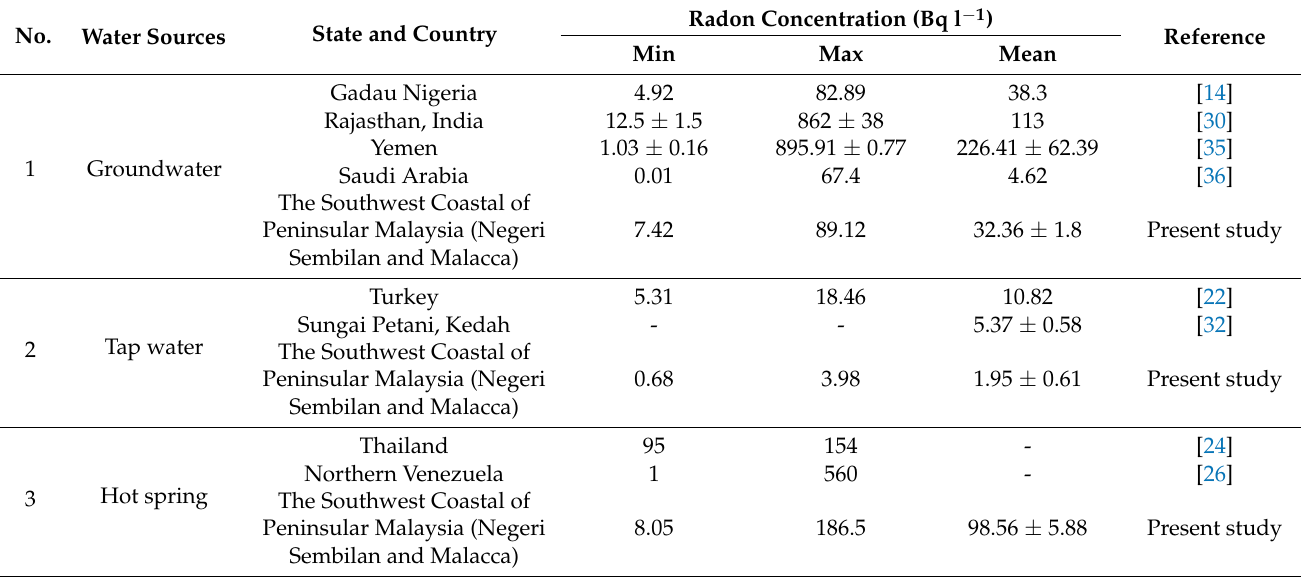
Table 2. Radon activity concentration in water in other parts of Malaysia and the